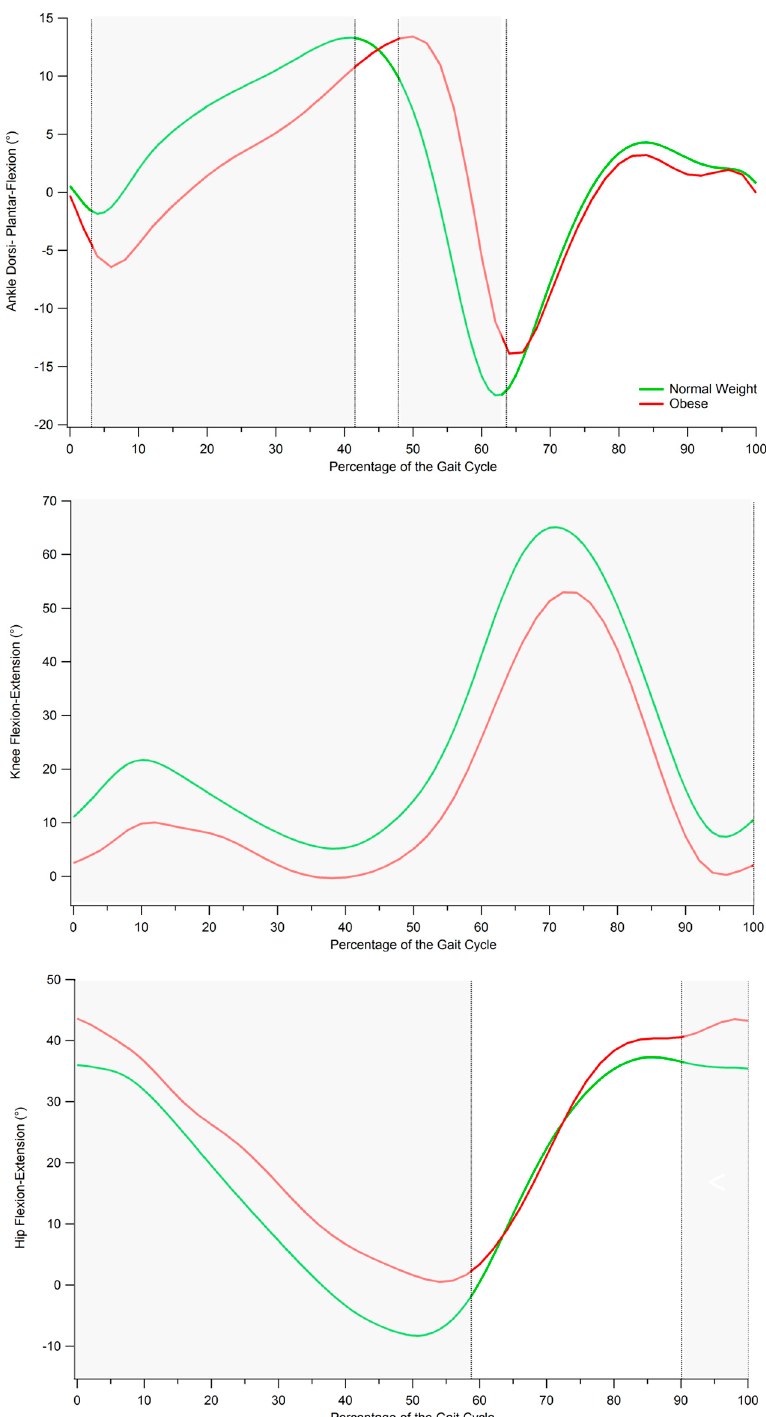
Figure 2. Gait kinematics in the sagittal plane for normal weight and obese individuals. From top to bottom: ankle dorsi-plantar-flexion, knee flexion-extension, and hip flexion-extension angles during gait cycle. Grey-shaded areas denote the periods of the gait cycle in which a significant difference between groups was detected ( p < 0.05).